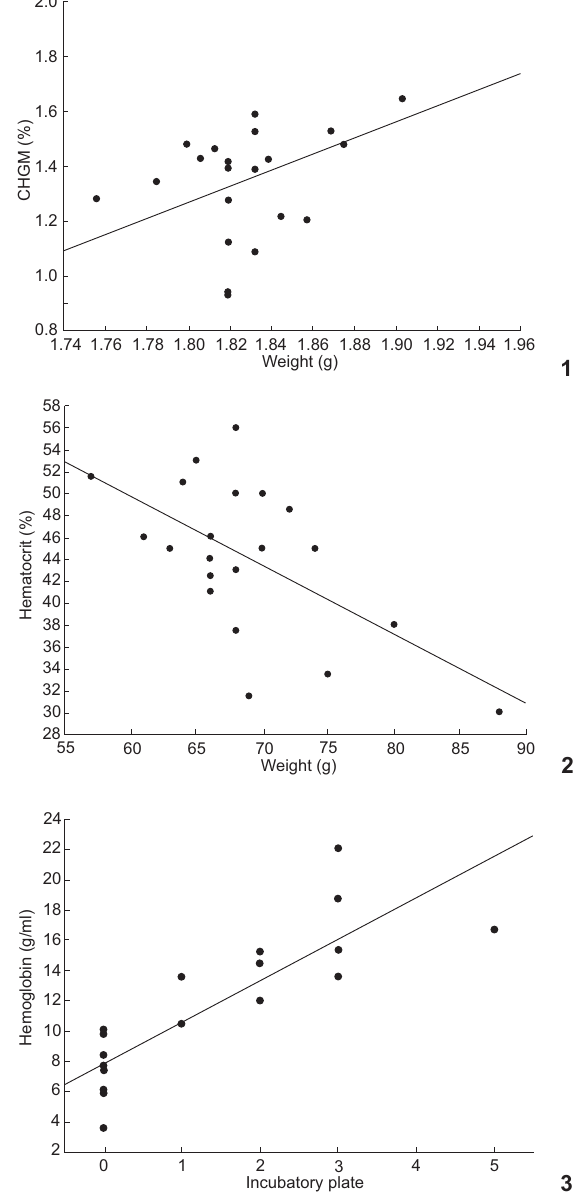
Figures 1-3. Linear regression between (1) log% CHGM and log weight (R = 0.71), (2) of hematocrit and weight (R = -0.62) and (3) hemoglobin concentration and the incubatory plate index (R = 0.89) of individuals of T . leucomelas in Parque Estadual Rio Preto.